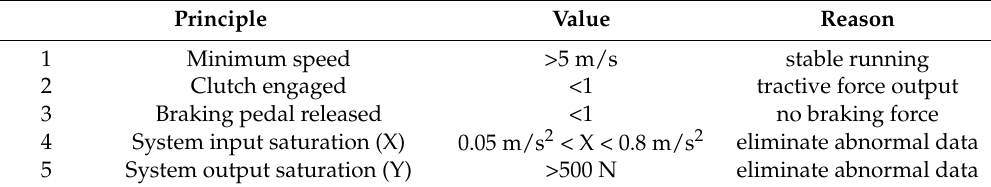
Table 1. Valid data principle.